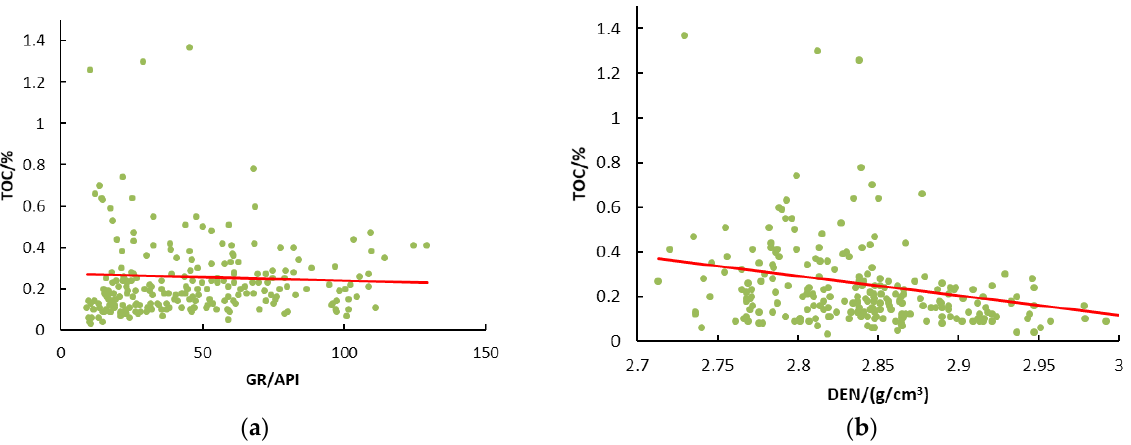
Figure 4. Scatter plot of intersection between original TOC data and some logging data: ( a ) natural gamma ray and ( b ) organic matter density.